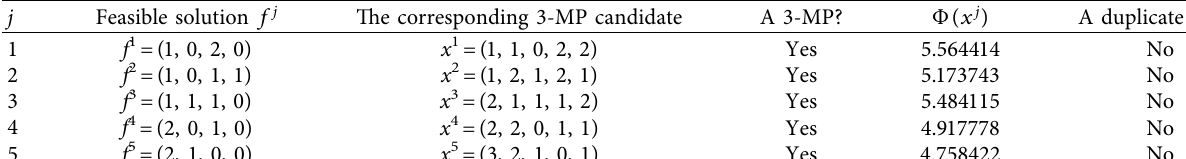
Table 2: Solution results of the proposed algorithm.